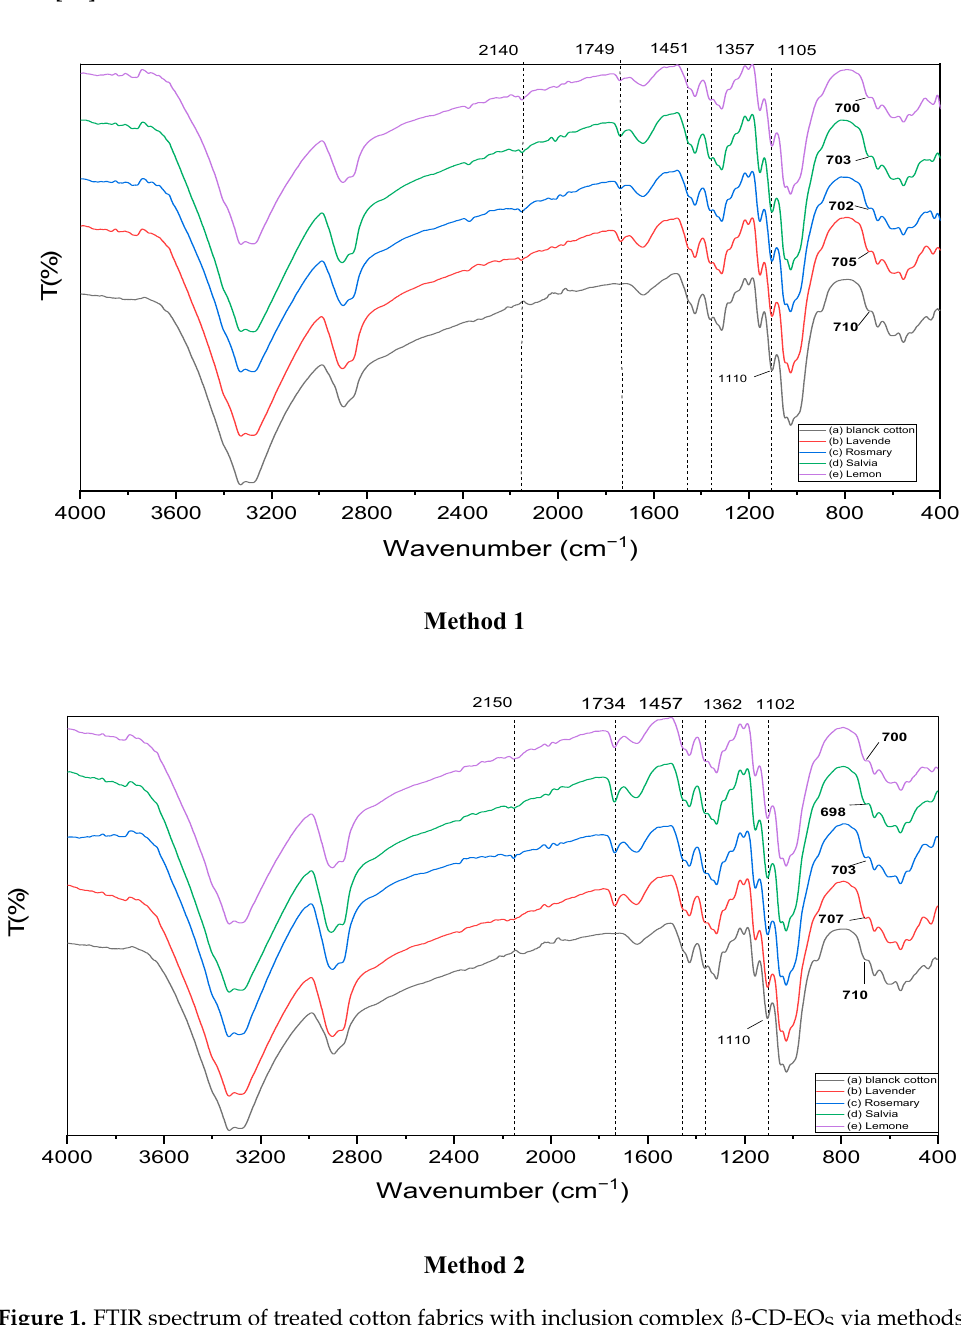
Figure 1. FTIR spectrum of treated cotton fabrics with inclusion complex β -CD-EO S via methods 1 and